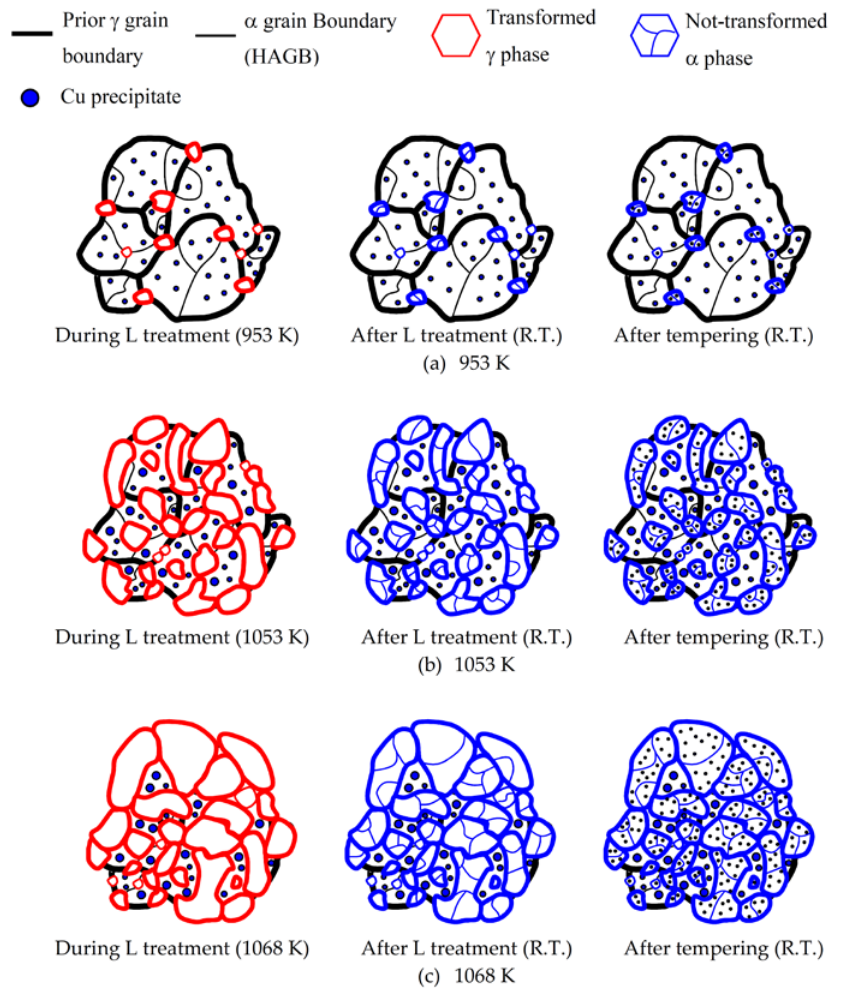
Figure 12. Schematic illustrations of changes in microstructure and precipitates during L treatment at 953 K ( a ), 1053 K ( b ), and 1068 K ( c ).